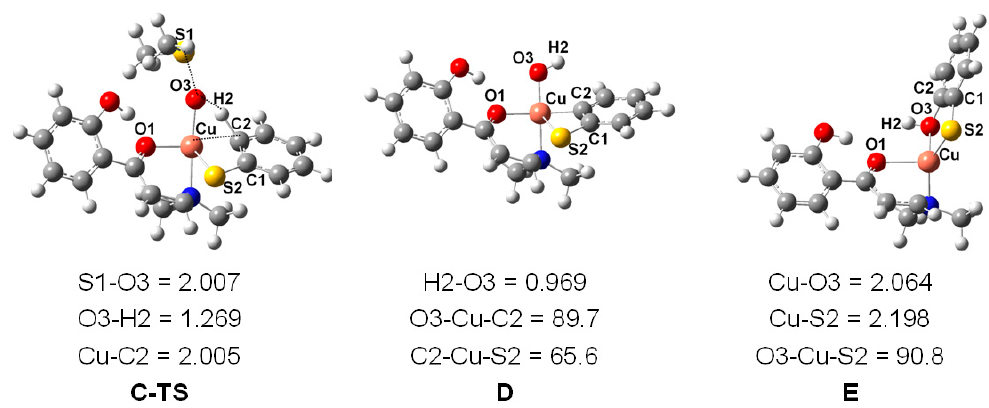
Figure 3. Optimized structures for C-TS and intermediates D and E .